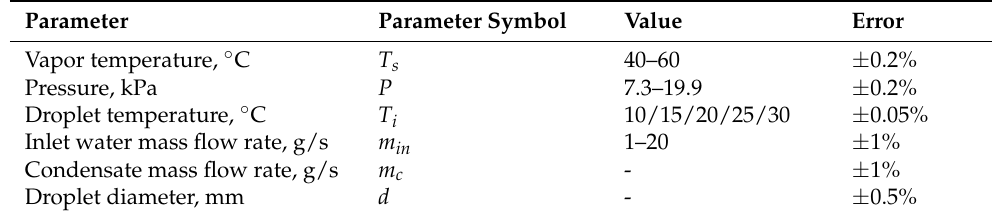
Table 1. Experimental